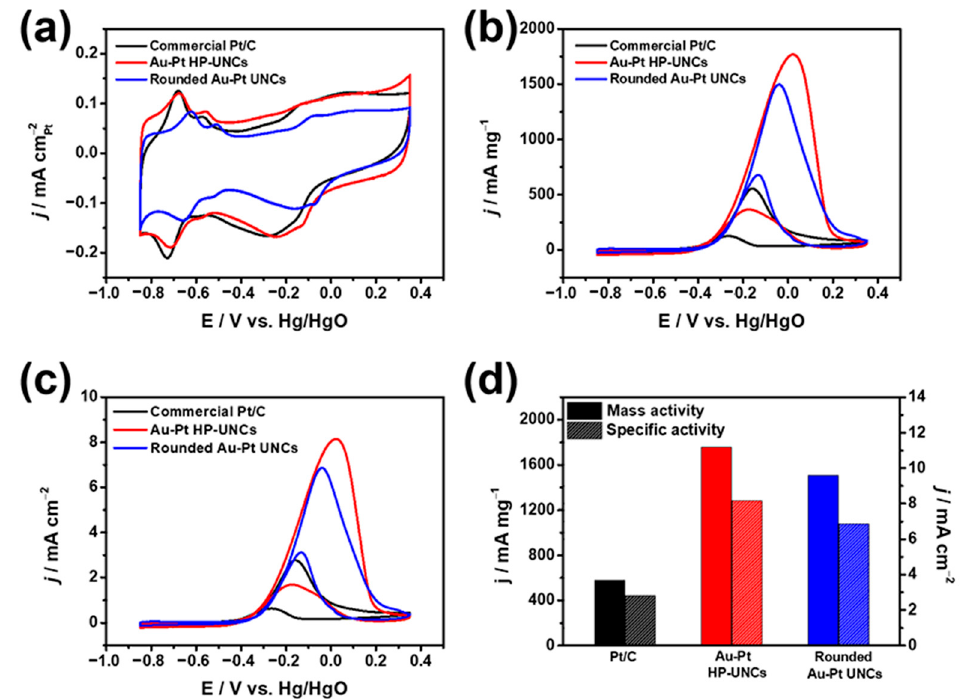
Figure 8. CVs obtained with various catalysts in ( a ) 0.1 M KOH and ( b , c ) 0.1 M KOH/0.5 M metha- at a scan rate of 50 mV s − 1 . Catalytic activities of different catalysts normalized by ( b ) mass of metal, nol at a scan rate of 50 mV s –1 . Catalytic activities of different catalysts normalized by ( b ) mass of and ( c ) ECSAs of catalysts. ( d ) Catalytic activities of various metal, and ( c ) ECSAs of catalysts. ( d ) Catalytic activities of various catalysts.